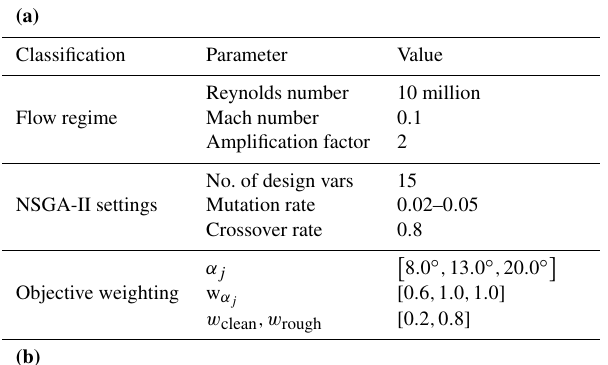
Table 1. General optimization settings (a) and optimization bound- ary conditions for the auxiliary slat design (b)